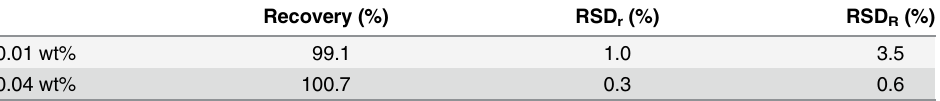
Table 1. Inter-day recoveries, repeatability, and intra-laboratory reproducibility of L, D-APM in L, L-APM.